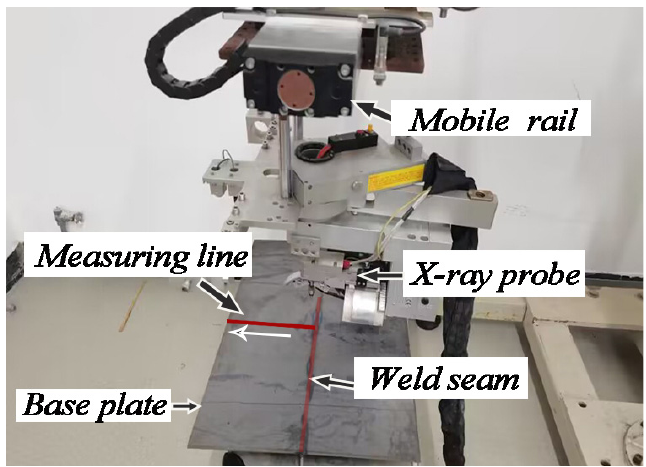
Figure 4. Schematic diagram of residual stress test.